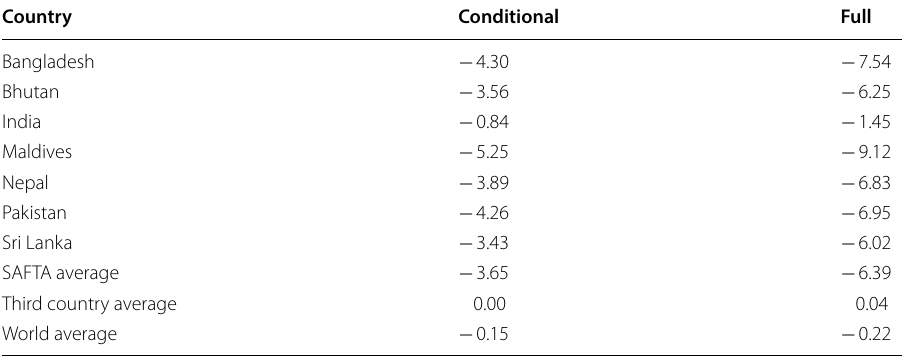
Table 11 Alternative approach to evaluate counterfactual effect of